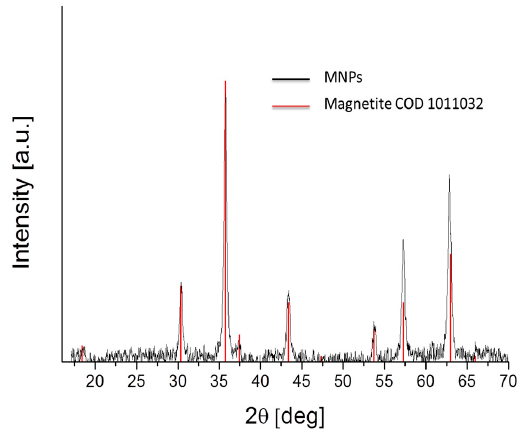
Figure 3. X-ray powder diffraction (XRD) diffraction pattern of Fe 3 O 4 synthesized nanoparticles. The vertical lines are the magnetite pattern (COD 1011032).